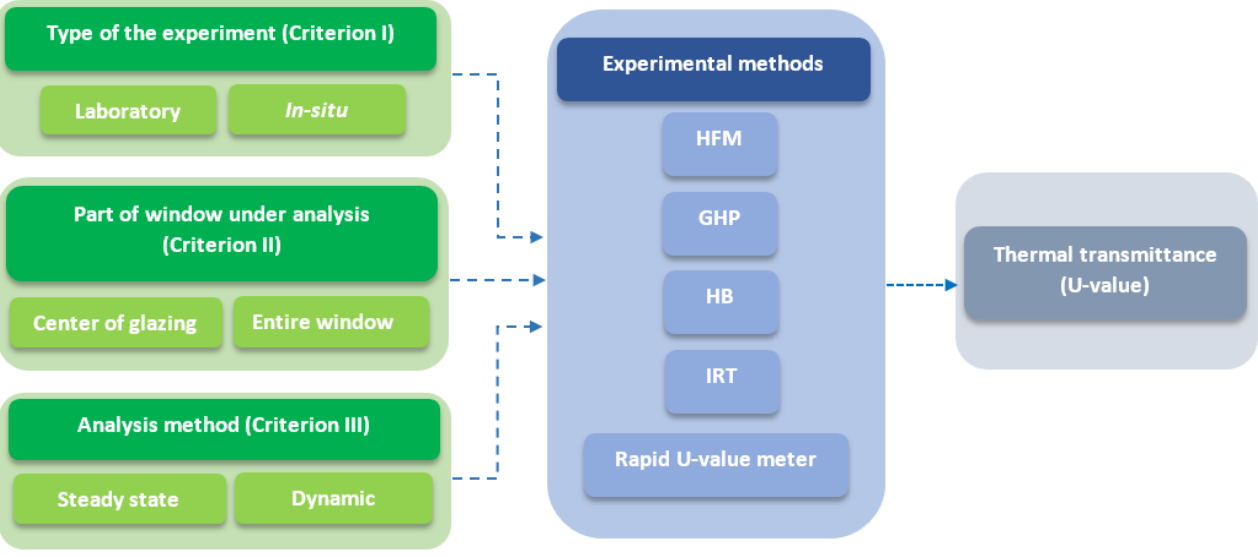
Figure 1. Schematic of the experimental methods for determining a windows’ U-value with respect to the three main analysis criteria.